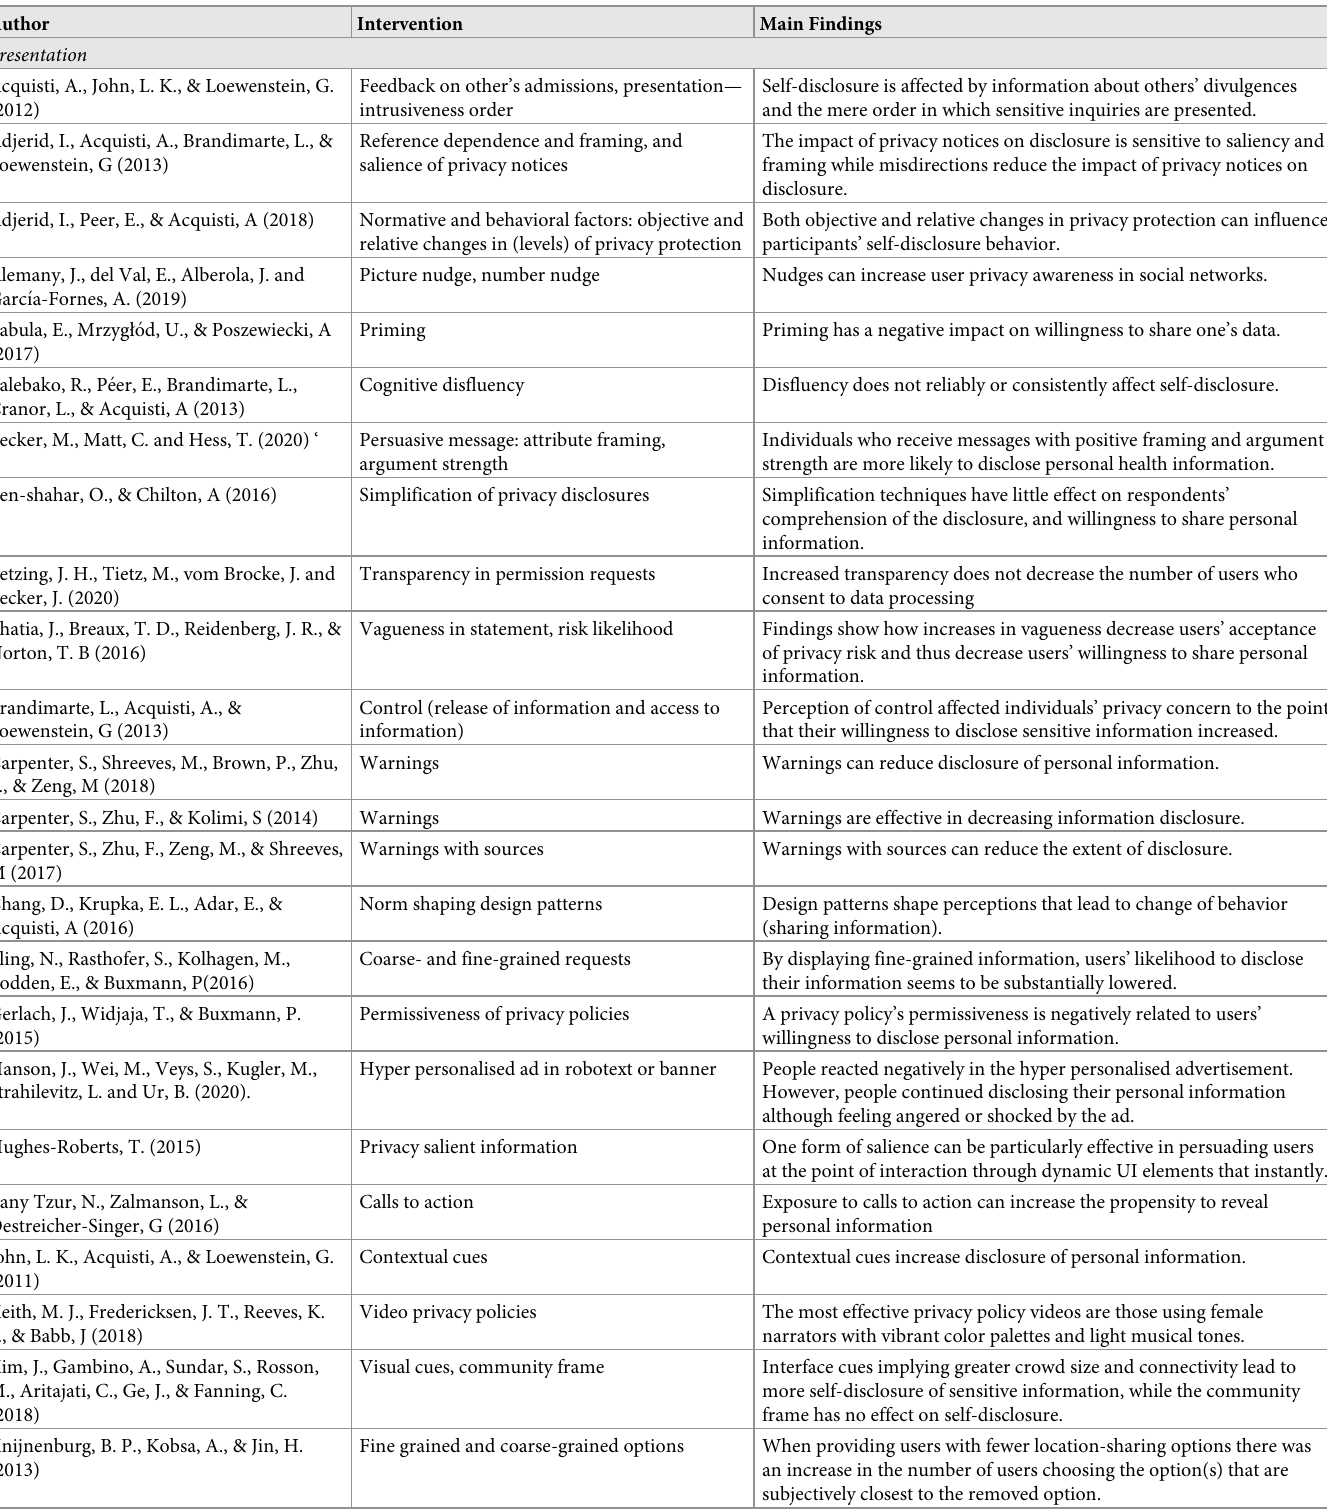
Table 3. Studies categorized by intervention (nudging)